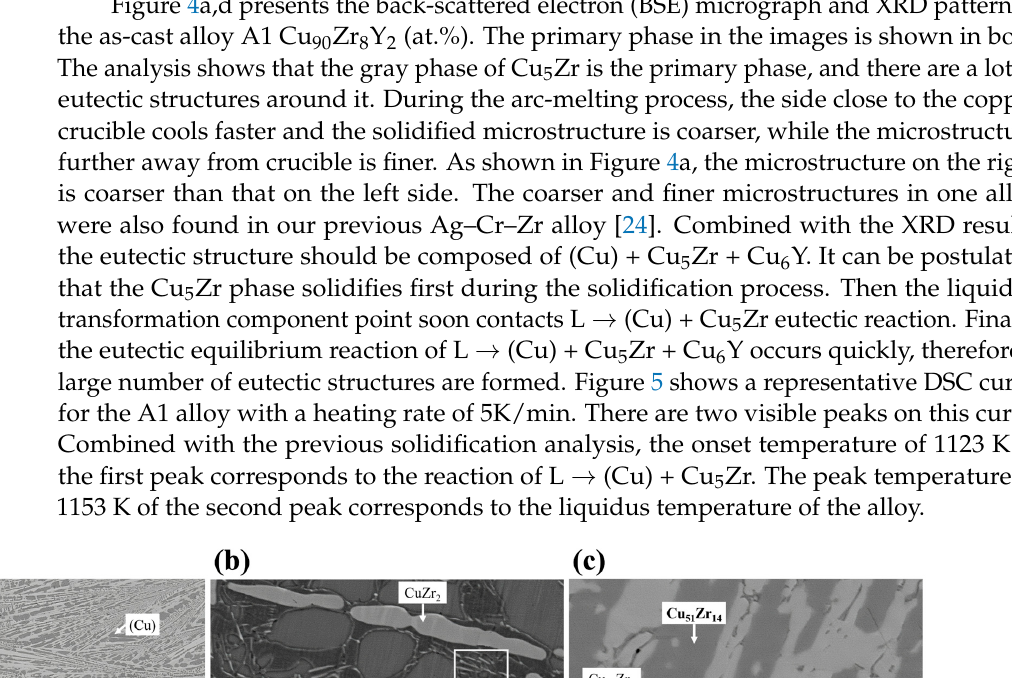
Figure 5. The DSC curves with a heating rate of 5 K/min for annealed alloy A1 Cu 90 Zr 8 Y 2 (at.%) of the Cu–Zr–Y system. 4.1.2. Microstructure of Annealed Alloys The experimental results of 12 alloys annealed at 973 K are summarized in Table 1. No ternary compound exists. Four two-phase regions, i.e., (Cu) + Cu 6 Y, (Cu) + Cu 5 Zr, Cu 51 Zr 14 + Cu 4 Y, Cu 51 Zr 14 + Cu 10 Zr 7 , and six three-phase regions, i.e., (Cu) + Cu 6 Y +Cu 5 Zr, Cu 10 Zr 7 + Cu 2 Y + Cu 7 Y 2 , ( α Y) + ( α Zr) + CuY, Cu 2 Y + CuZr 2 + CuZr, Cu 2 Y + CuZr 2 + CuY, ( α Zr) + CuZr 2 + CuY, are determined experimentally. The relationships are discussed as follows.